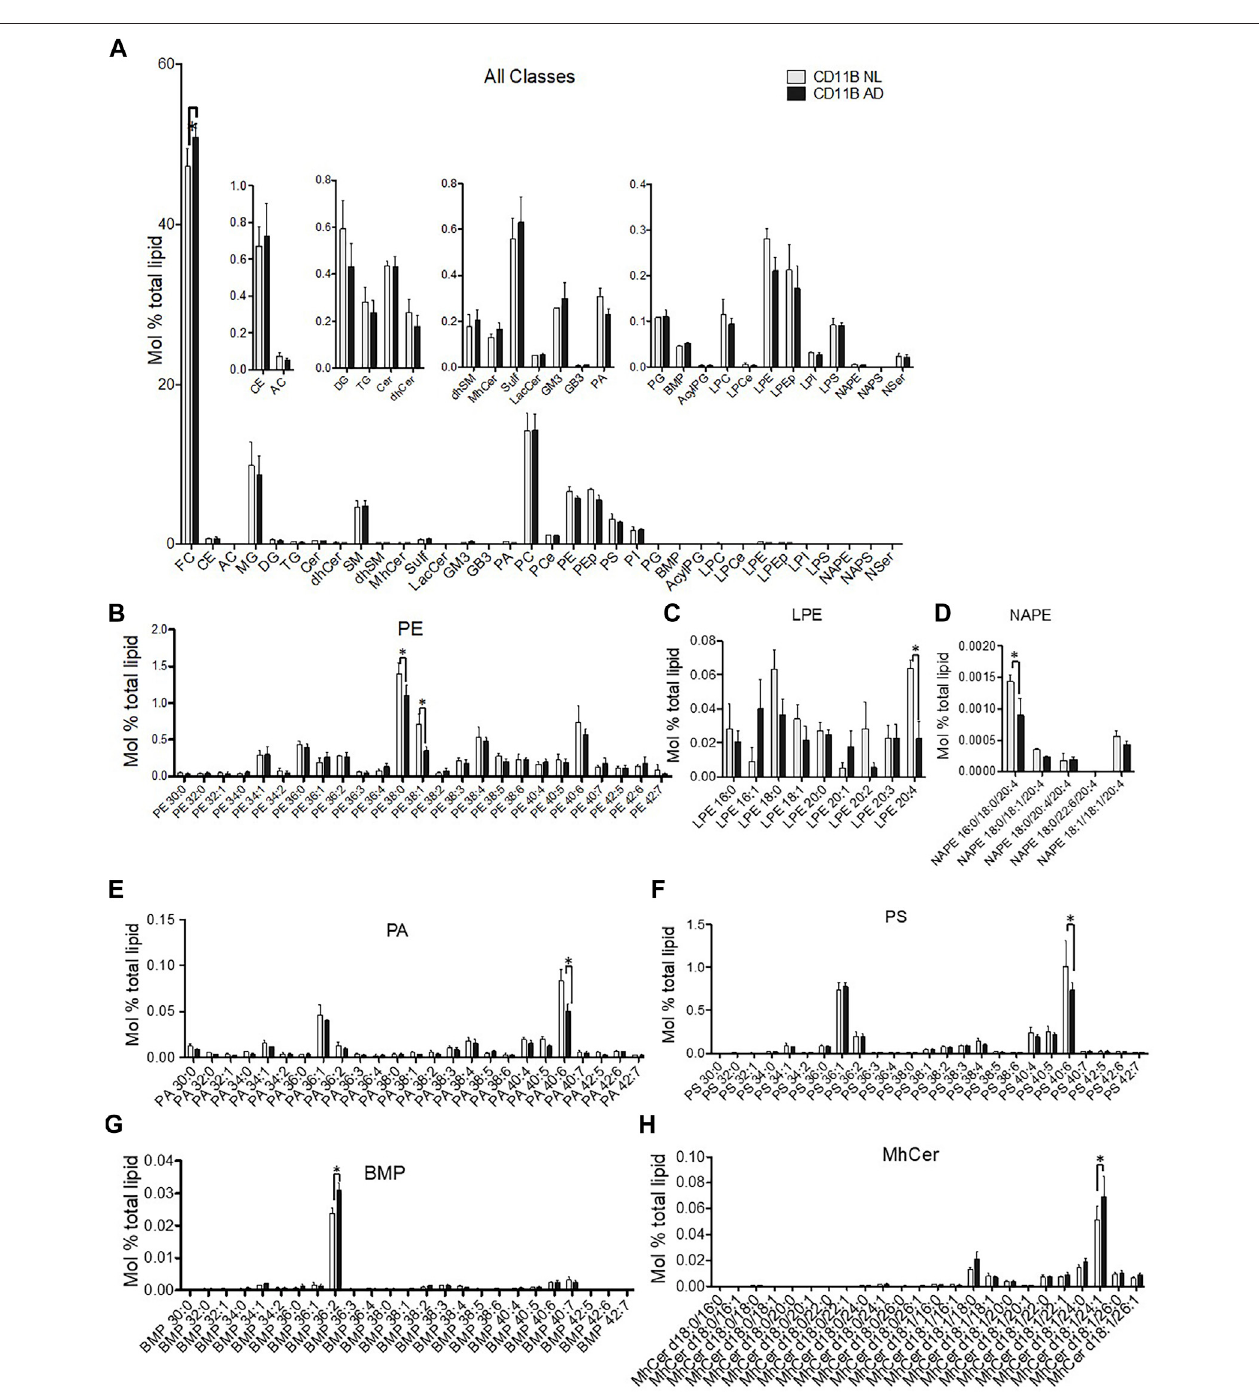
FIGURE 4 | Lipidomic analysis of microglial EVs from normal/low pathology and late-stage AD cases. (A) Relative quanti fi cation 34 lipid classes and 593 individual lipidspeciesinmicroglialEVs.Lipidsarequanti fi edasmol%totallipidbynormalizingthemolaramountofeachlipidspeciestothesummedtotalmolesofalllipidspecies in each sample. The inset panels show lower abundance species on the expanded y -axis. Abbreviations are free cholesterol (FC), cholesteryl ester (CE), acyl carnitine (AC), monoacylglycerol (MG), diacylglycerol (DG), triacylglycerol (TG), ceramide (Cer), sphingomyelin (SM), monohexosylceramide (MhCer), sulfatides (Sulf), lactosylceramide (LacCer), monosialodihexosylganglioside (GM3), globotriaosylceramide (GB3), phosphatidic acid (PA), phosphatidylcholine (PC), ether phosphatidylcholine (PCe), phosphatidylethanolamine (PE), plasmalogen phosphatidylethanolamine (Pep), phosphatidylserine (PS), phosphatidylinositol (PI), phosphatidylglycerol (PG), bis(monoacylglycerol)phosphate (BMP), acyl phosphatidylglycerol (AcylPG), lysophosphatidylcholine (LPC), ether lysophosphatidylcholine (LPCe), lysophosphatidylethanolamine (LPE), plasmalogen lysophosphatidylethanolamine (LPEp), lysophosphatidylinositol (LPI), lysophosphatidylserine (LPS), N-Acyl